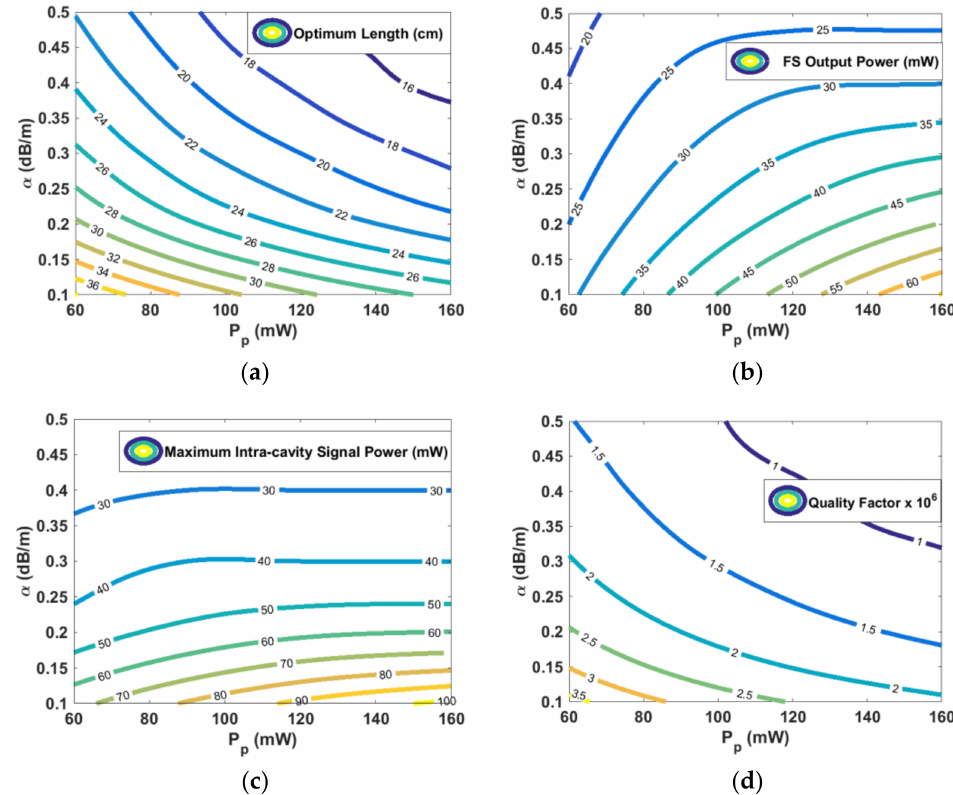
Figure 4. Contour maps for ( a ) optimum cavity length, ( b ) maximum FS output power, ( c ) maxi- mum intra-cavity signal power, and ( d ) quality factor, considering various pump power and fiber background